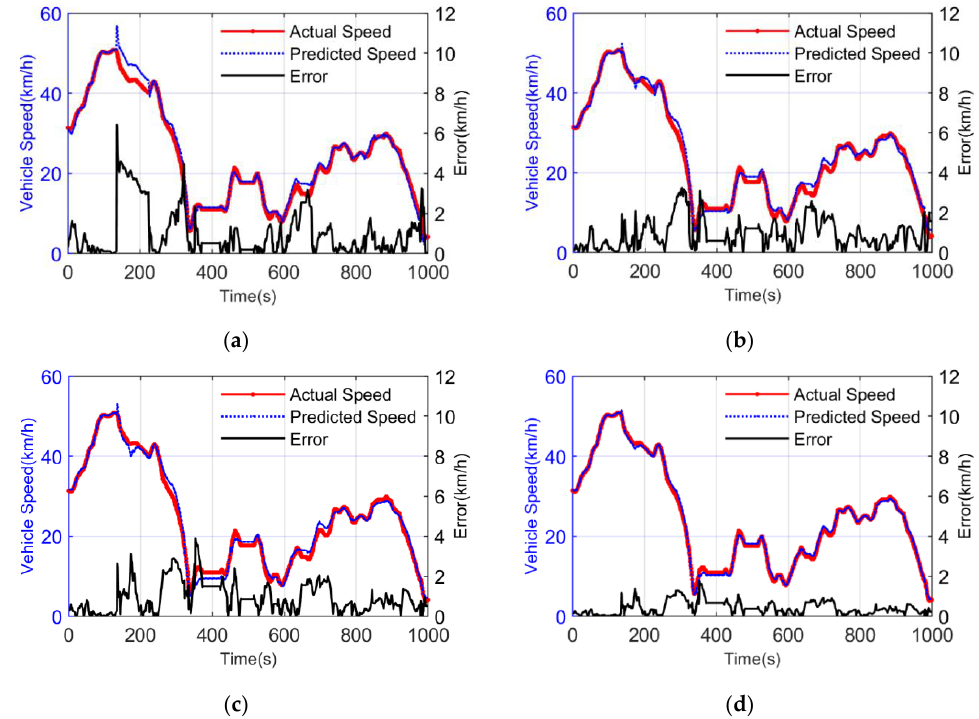
Figure 8. The speed prediction results and prediction error of four methods. ( a ) BPNN speed prediction; ( b ) LSSVM speed prediction; ( c ) APSO LSSVM speed prediction; ( d ) APSO LSSVM and BP NN speed prediction.